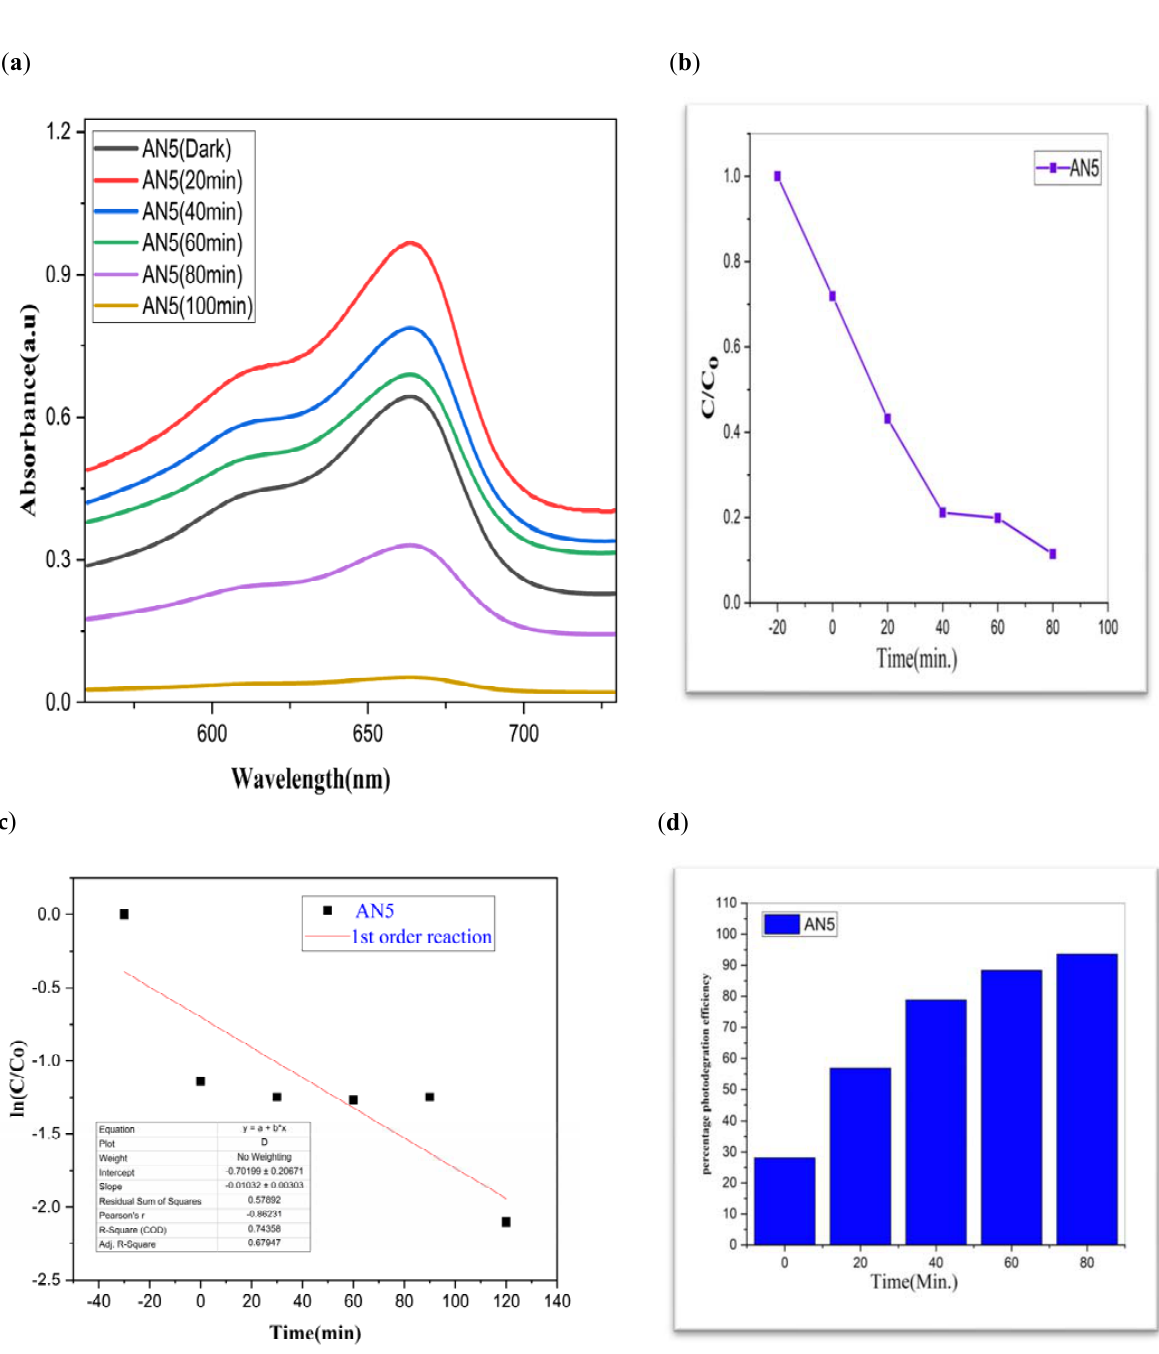
Figure 9. AN5 ( a ) graphical representation of degradation of methylene blue; ( b ) C/C 0 ; ( c ) lnC/C 0 ; ( d ) %age e ffi ciency.